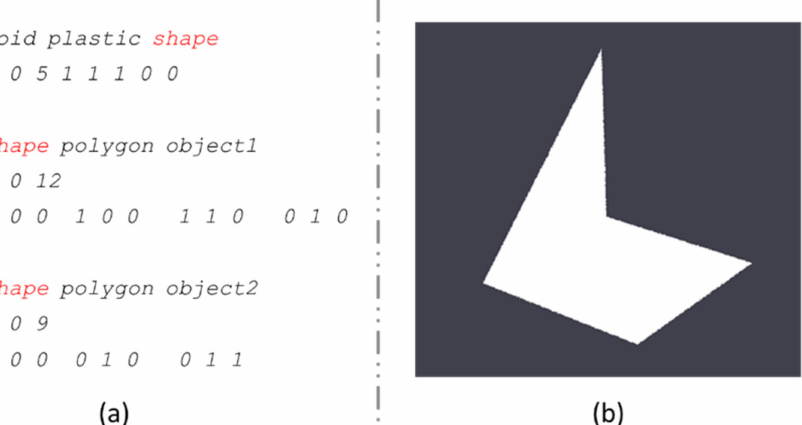
Figure 7. A surface comprised of two polygons and same material. ( a ) Shows the definition of the surface in ASCII format and ( b ) shows a RADIANCE-rendered image of the surface.